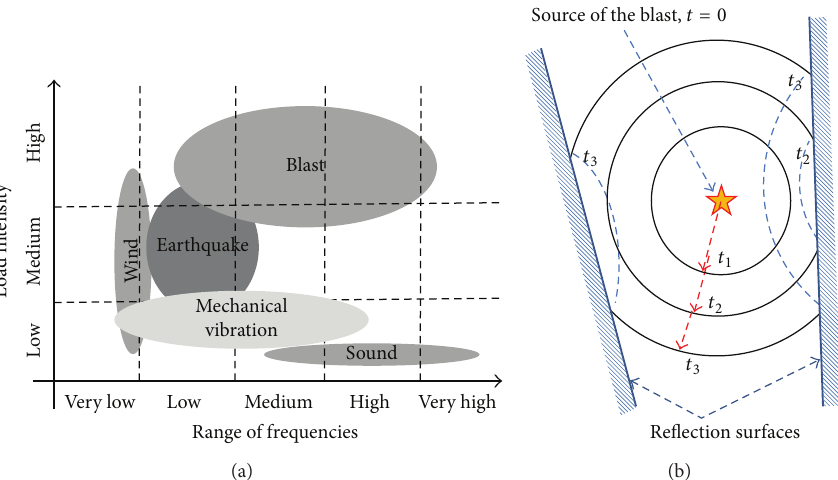
Figure 1: (a) Frequency range of different dynamic loads (according to [1]). (b) Collision and reflection of aerial blast waves ( 𝑡 𝑖 are arrival times of the expanding wave front).